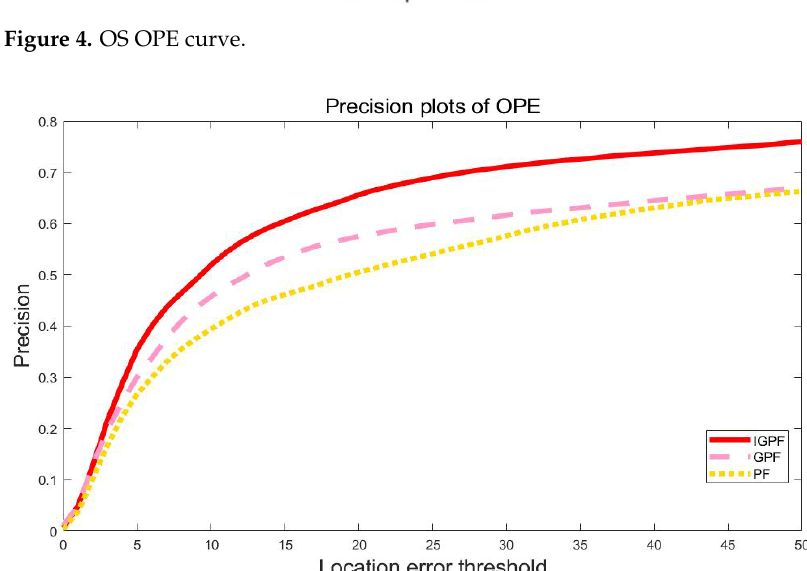
Figure 5. DP OPE Figure 5. DP OPE curve. Figure 5. DP OPE curve.